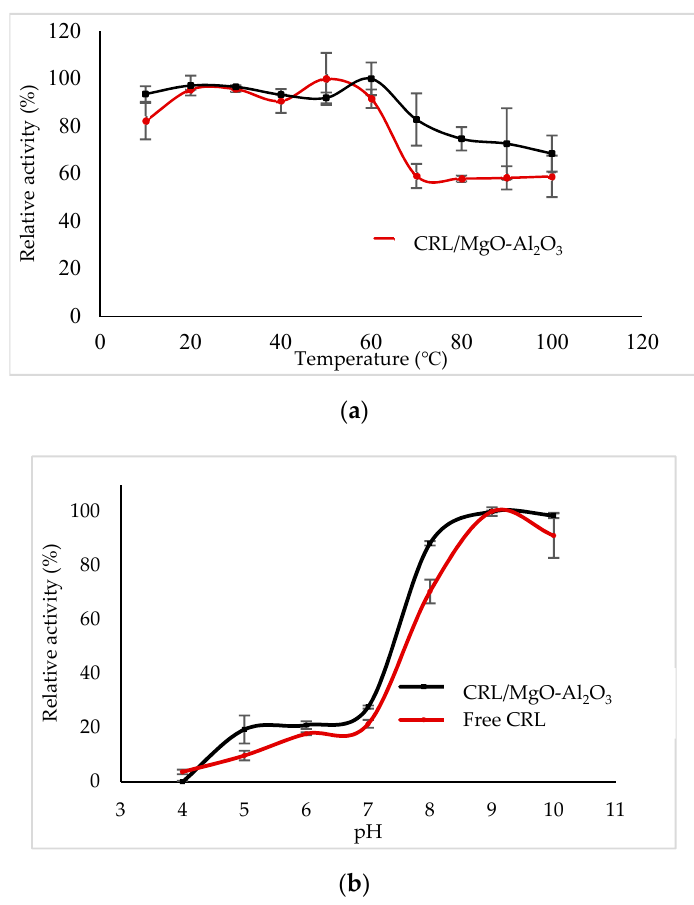
Figure 6. ( a ) Optimum temperature of free CRL and CRL/MgO-Al 2 O 3 at 60 and 50 °C, respectively while ( b ) pH optimum for free CRL and CRL/MgO-Al 2 O 3 at pH 9. The highest activity of free CRL and CRL/MgO-Al 2 O 3 was defined as 100% of relative activity. The error bars show standard deviations; all studies were conducted in triplicate.